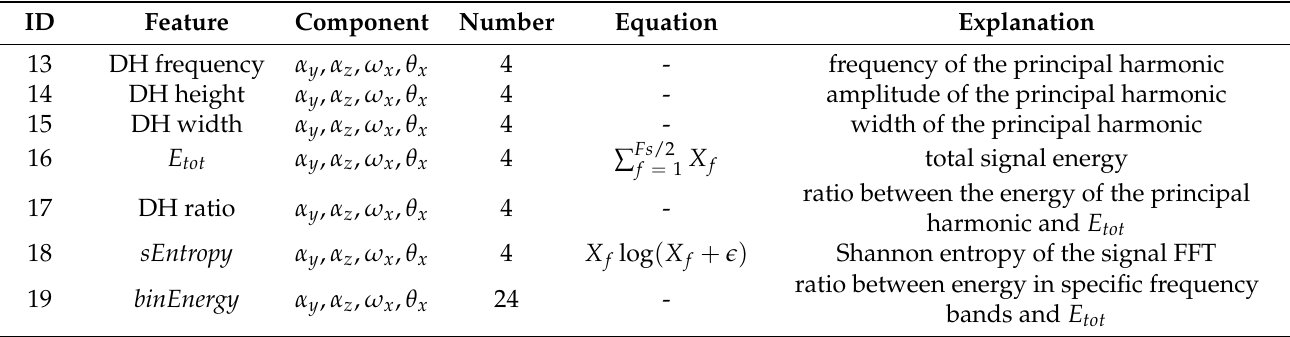
Table 5. List of spectral-domain features extracted in the present study, together with equations and some brief explanations. α : acceleration; ω : angular velocity; θ :